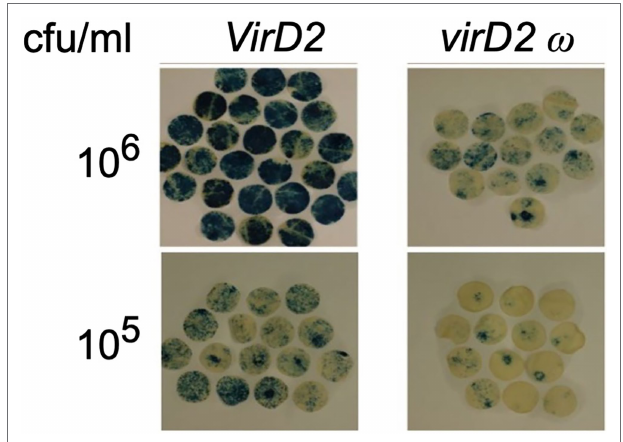
FIGURE 5 | Transient expression of GUS activity in N. benthamiana leaves agroinfiltrated with Agrobacterium containing a wild-type VirD2 gene (left panels) or the virD2 ω mutant (right panel). Agrobacterium tumefaciens containing a wild-type virD2 gene, the AMP-ORI T-circle binary vector, and the T-DNA binary vector pBISN1 or a similar strain with the ω mutant virD2 gene were infiltrated at the indicated concentration. Discs cut from leaves after 4 days were stained with X-gluc, cleared with 70% ethanol, and the relative staining intensity calculated using ImageJ software. cfu, colony forming units.